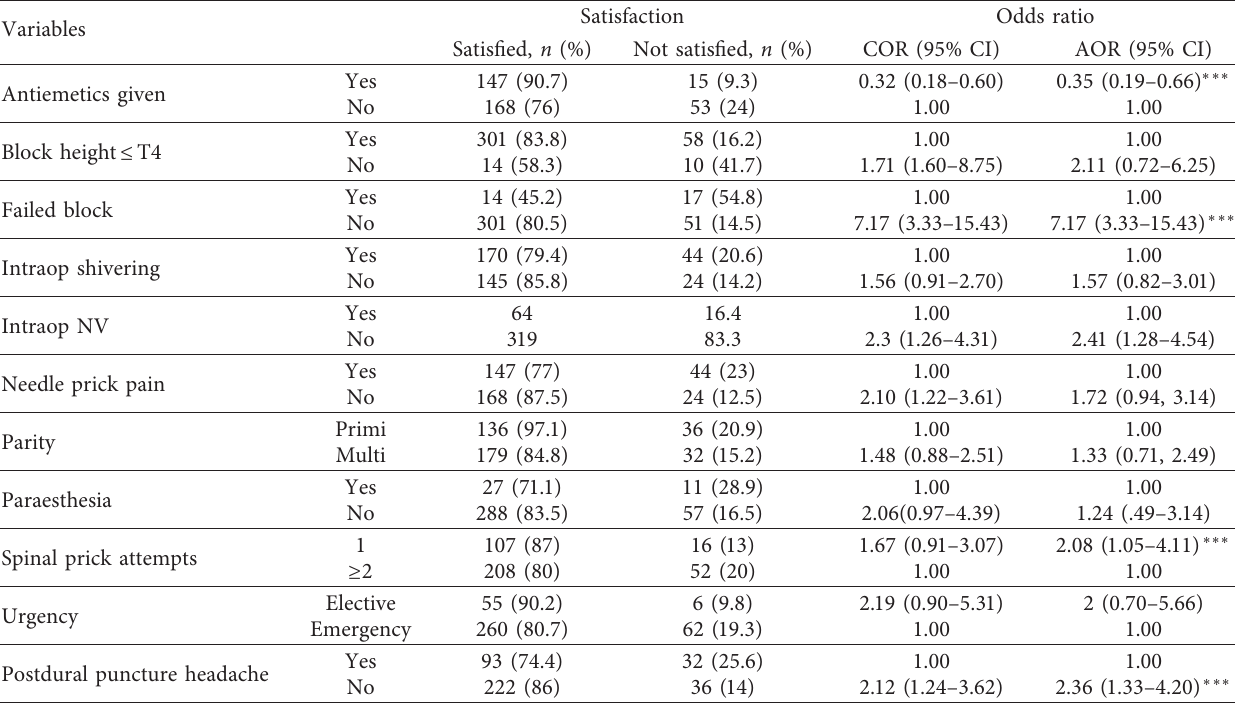
Table 5: Multivariable binary logistic regression on possible risk factors of maternal satisfaction among parturients who underwent spinal anesthesia at University of Gondar Comprehensive Specialized Hospital, Northwest Ethiopia, 2019 ( N � 383).